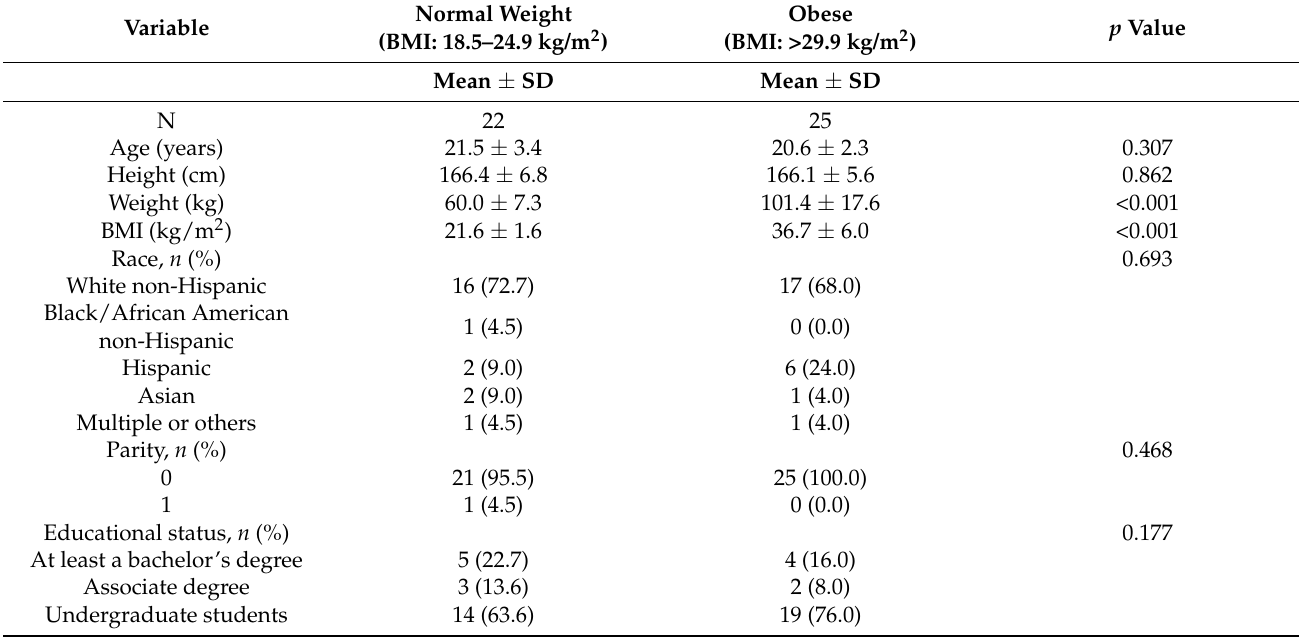
Table 1. Characteristics of study participants (normal weight and obese women) ( n =